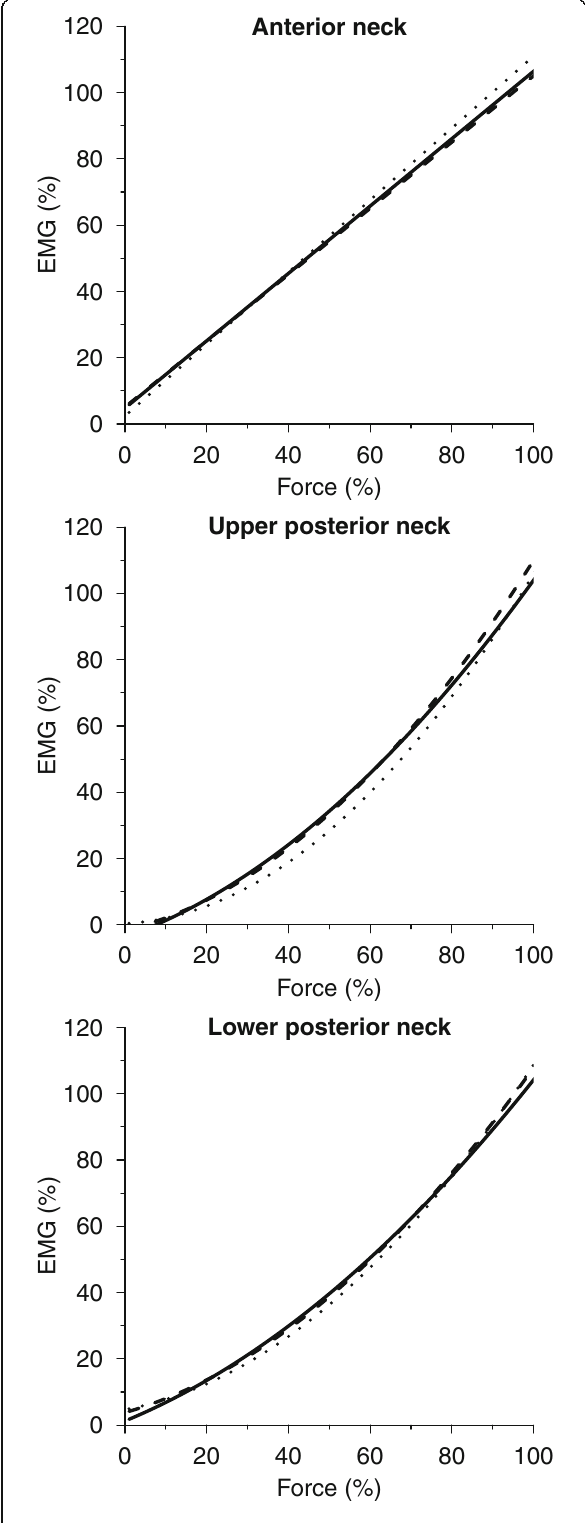
Fig. 4 By-trial fitted regression lines. Solid , dashed , and dotted lines denote by-trial fitted regression lines for the first day ’ s morning session, the first day ’ s afternoon session, and the second day ’ s morning session,